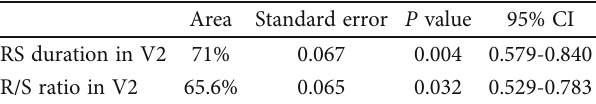
Figure 3: The receiver-operator characteristic analysis of the R/S ratio in lead V2. Table 5: ROC analysis of RS duration in V2 and R/S ratio in